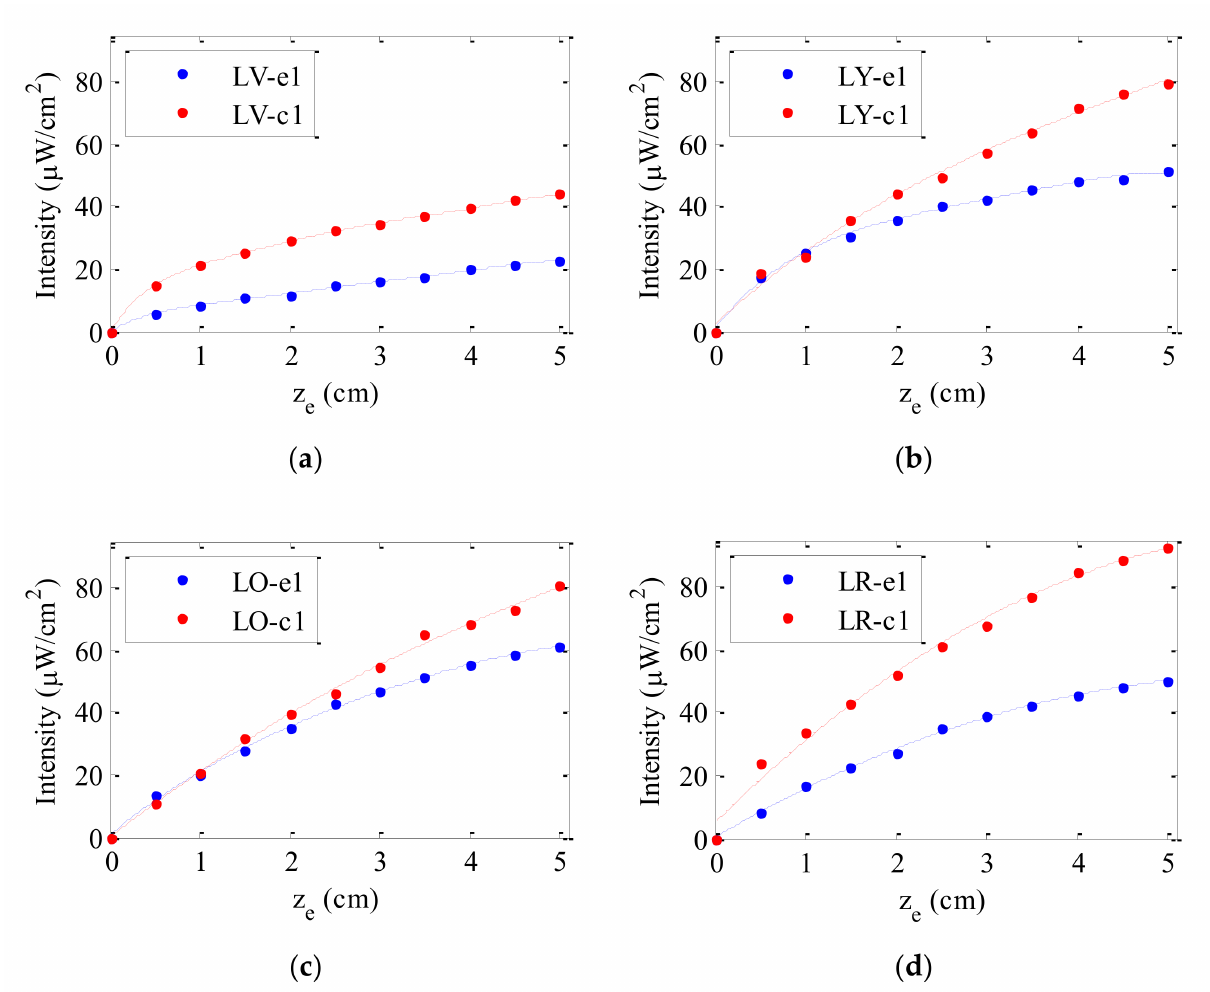
Figure 4. Output intensity as a function of the illuminated length on the fiber (z e ) for ( a ) LV, ( b ) LY, ( c ) LO and ( d ) LR samples under sun-simulator lamp exposure; the solid-lines are guides to the